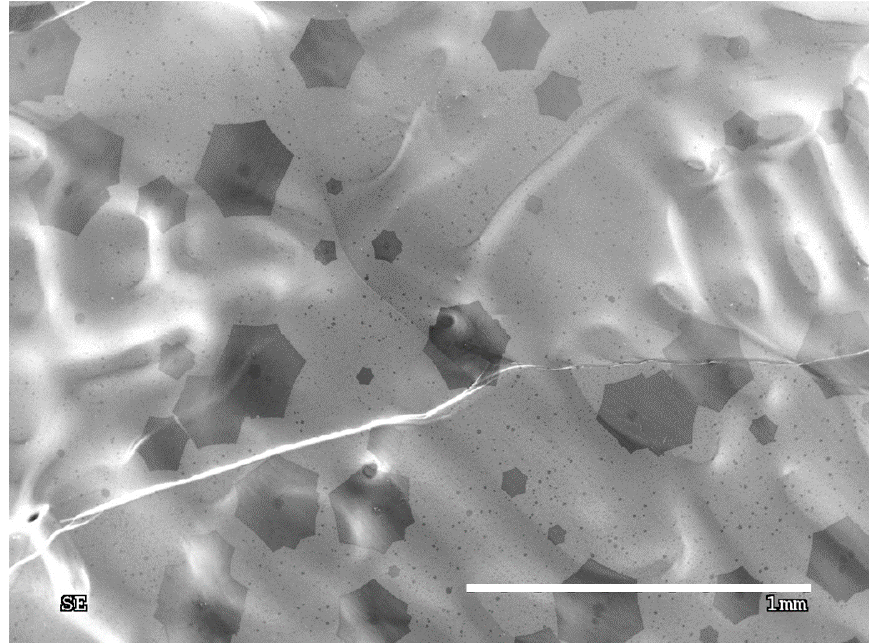
Figure 5. SEM image of a reduced number of nuclei, which are able to rotate and rearrange until fitting perfectly to each other.